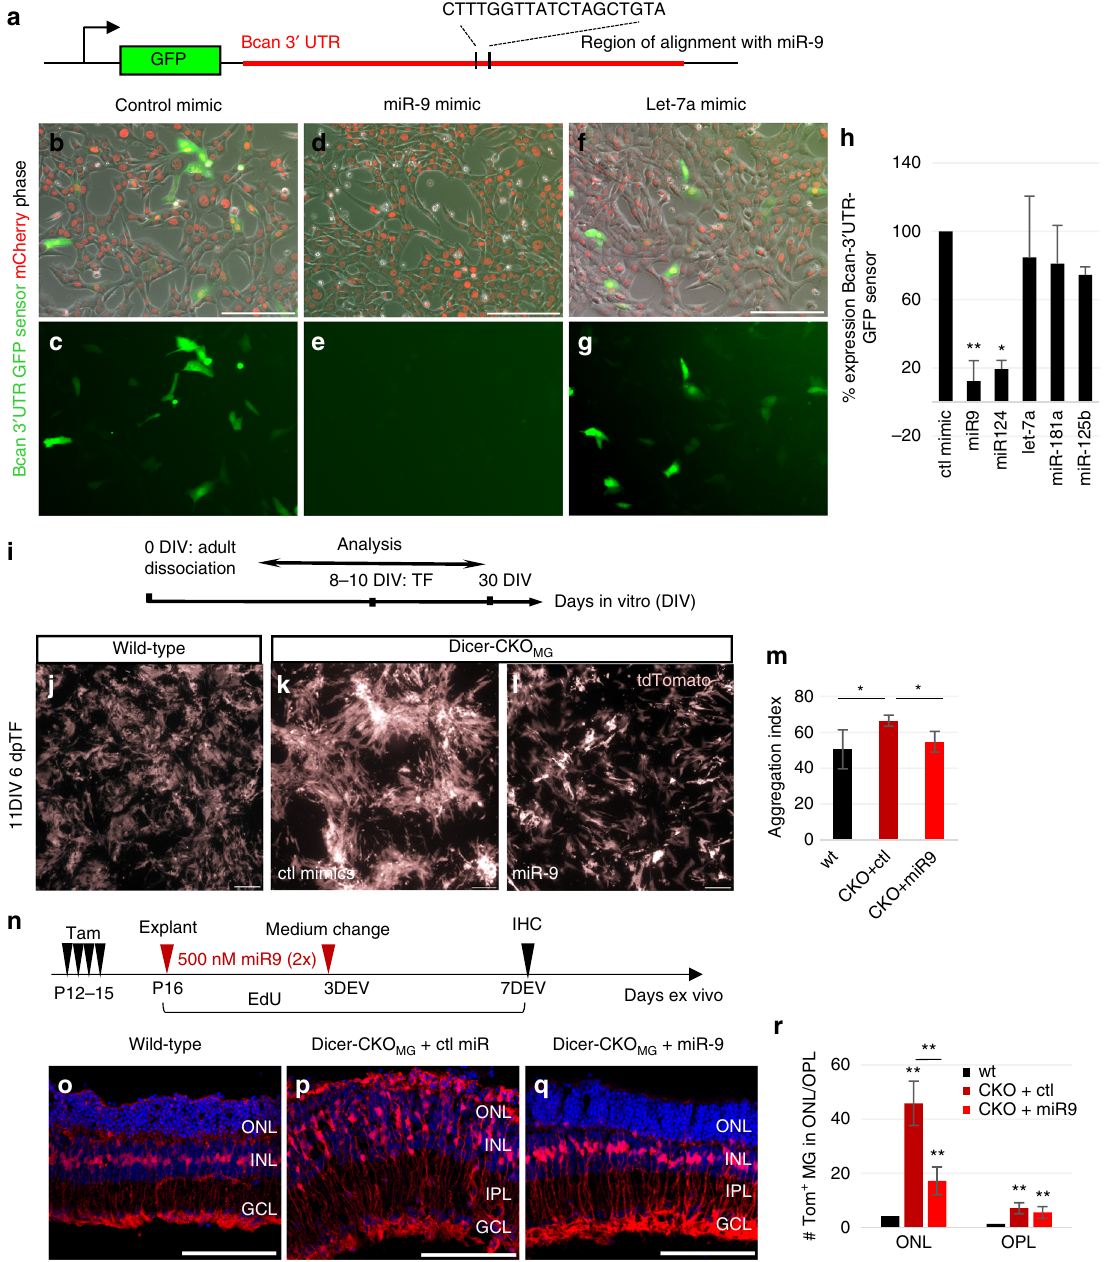
Fig. 6 miR-9 targets Bcan and regulates Müller glial morphology. a Schematic of the Bcan 3 ′ UTR-GFP sensor. b – g Live images of 3T3 cells fi broblasts transfected with the Bcan 3 ′ UTR sensor (plasmid) and mCherry mRNA transfection control with either control mimics or mimics for miR-9 or let-7a. h Quanti fi cation of the number of Bcan 3 ′ UTR-GFP sensor + 3T3 cells of the total number of transfected cells ( n ctl = 5, n miR-9 = 5, n miR-124 = 4, n let-7a = 4 n miR- = 2, and n = 2 individual experiments for two wells per condition per experiment). i Cell culture and transfection (TF) scheme. j – l Live images miR-125b-5p 181a of wt MG ( j ) and Dicer-CKO MG cultures ( k , l ) treated with control or miR-9 mimics. m Quanti fi cation of the aggregation index of wt, and Dicer-CKO MG either transfected with control miR or miR-9, n = 3 mice for each condition. This experiment was performed four times in the laboratory. n Experimental design explant cultures. o – q Immuno fl uorescent labeling with antibodies against tdTomato and DAPI nuclear staining of P16 wt ( o ), Dicer-CKO MG with control mimics ( p ), and Dicer-CKO MG explant cultures treated with miR-9 mimics ( q ), 7 days ex vivo (DEV). r Numbers of tdTomato + MG per fi eld in the ONL/OPL in wt ( n = 3 mice) and Dicer-CKO MG + control miR ( n = 3 mice) and Dicer-CKO MG explants treated with miR-9 mimics ( n = 3 mice). This experiment was performed twice in the laboratory. Statistics: mean ± S.D., Shapiro – Wilk test for normality, for h , r : Mann – Whitney U -test, for m : Levene ’ s test for equality of variances and independent samples t -test (2-tailed) as well as Bonferroni – Holm correction for all tests, signi fi cant differences are indicated, * p < 0.05, ** p < 0.01, *** p < 0.0001. Scale bars 100 μ m. dpTF, days post transfection; ONL, INL, GCL as de fi ned in Fig. 1